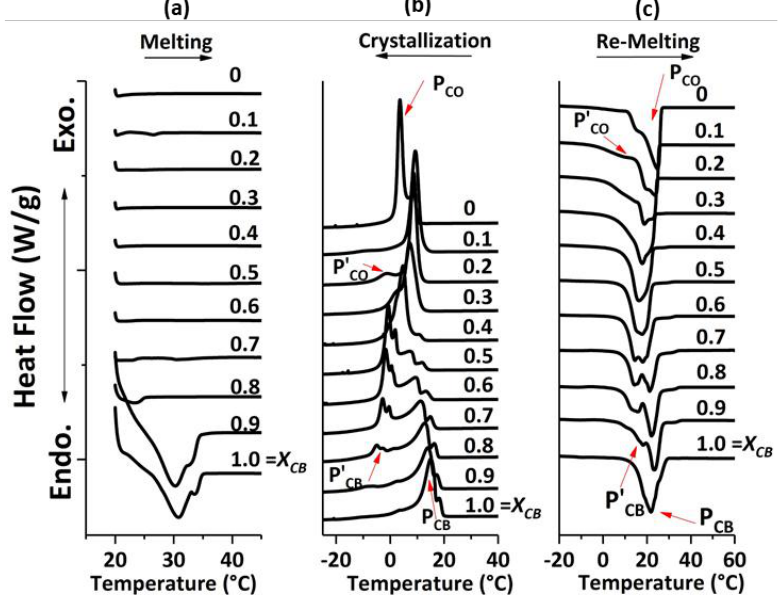
Figure 4. DSC analysis of CB / CO blends. ( a ) Melting process after crystallization for 24 h at 22 ◦ C. ( b ) Dynamic crystallization from 90 ◦ C to − 50 ◦ C. ( c ) Remelting of crystals formed in segment ( b ). The arrows indicate the peak of CB (P CB ), the peak representing CO (P CO ), shoulder peaks appearing after the addition of CO in CB (P’ CB ) and shoulder peaks appearing after the addition of CB in CO (P’ CO ). The results of crystallization are shown in Figure 4b. P CB represents the main peak for CB in all mixtures; P’ CB indicates the shoulder peaks, which were appearing after the addition of CO in CB.